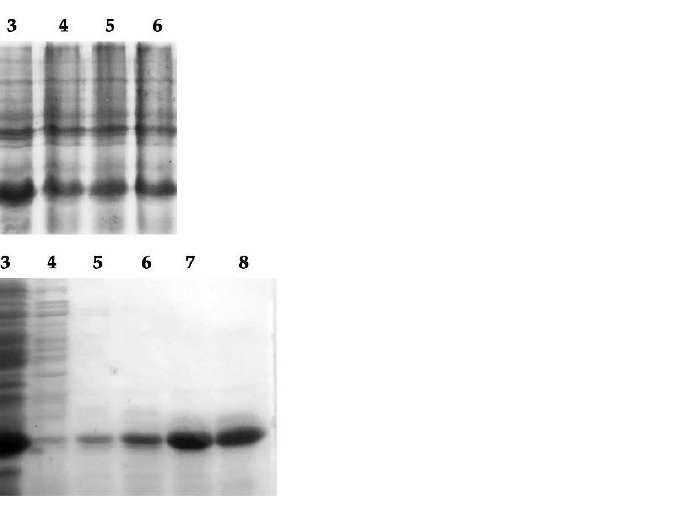
Figure 5. SDS-PAGE analysis of recombinant protein EparOBP2 expression and purification. ( A ):